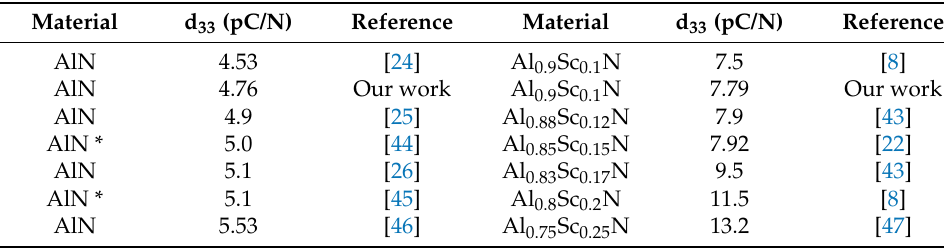
Table 2. d 33 comparison with other